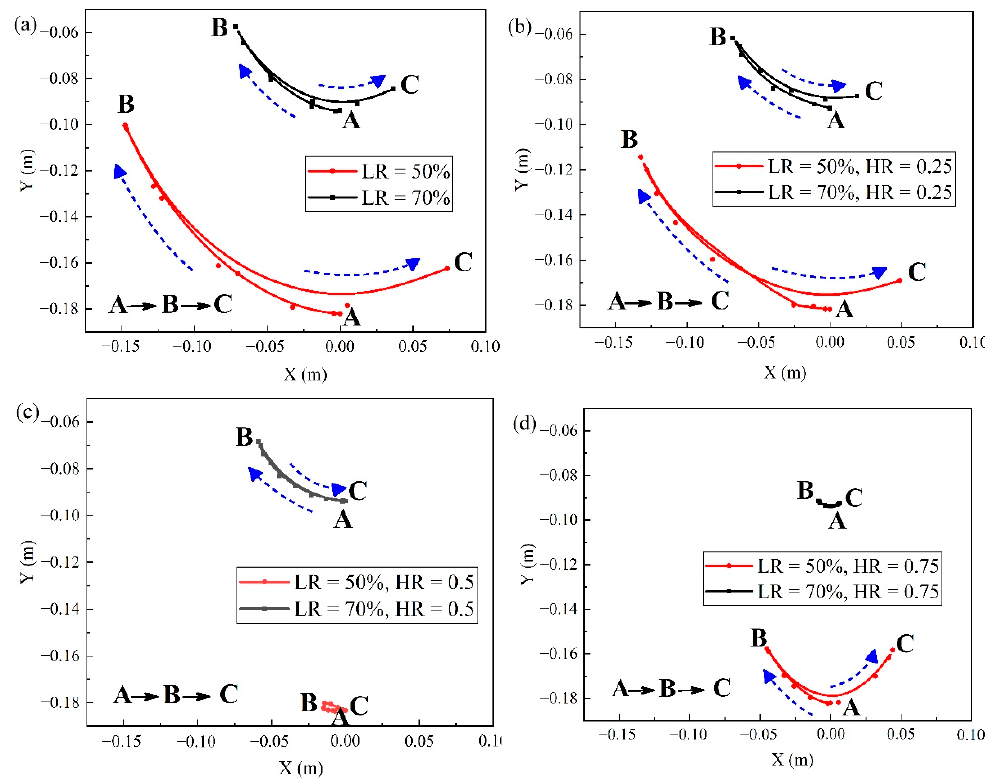
Figure 19. Centroid displacement with various LR values and HR values. ( a ) non-baffle; ( b ) baffle with HR = 0.25; ( c ) baffle with HR = 0.5; ( d ) baffle with HR = 0.75